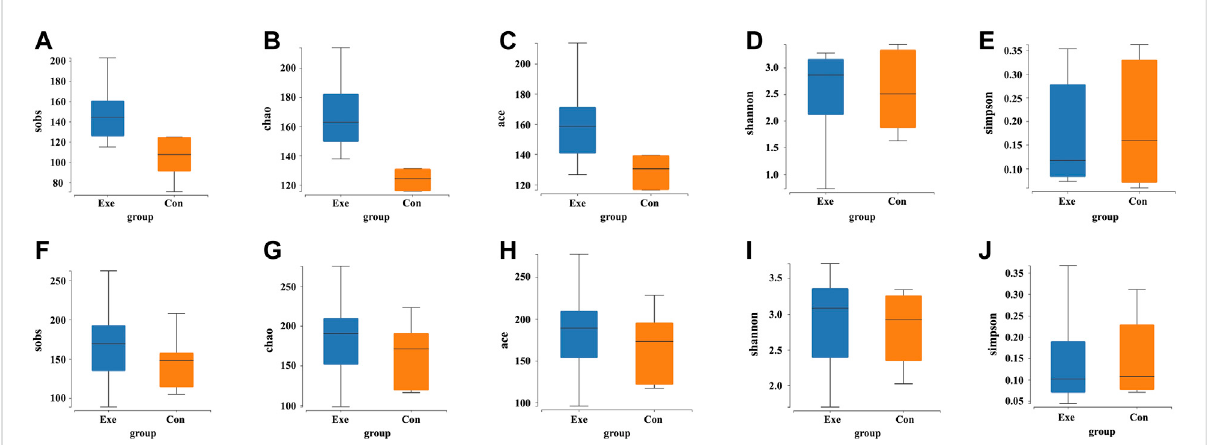
FIGURE 2 Changesinthealphadiversityindicesofgutmicrobiotaafterexercisetraining.Exe:combinedaerobicandresistanceexercise,Con:maintaining